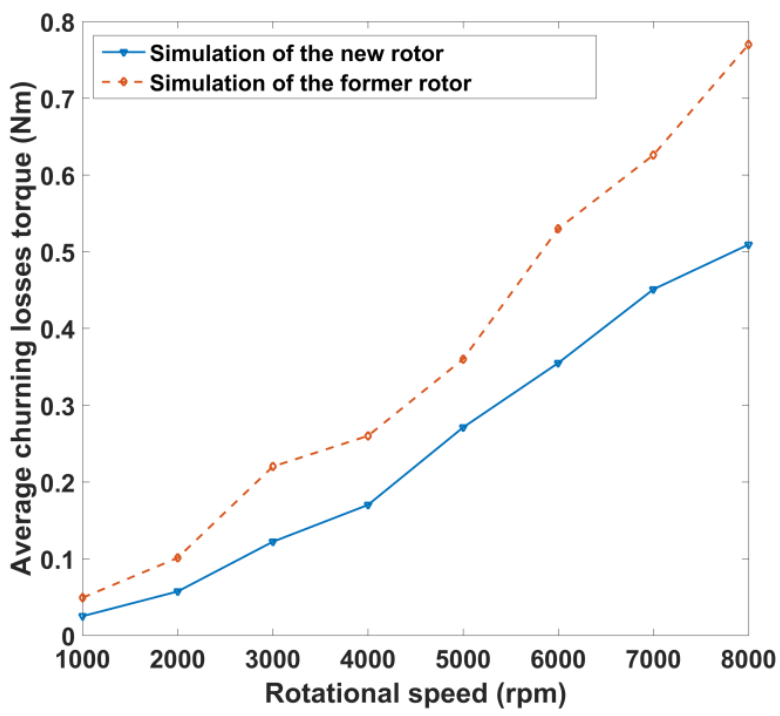
Figure 8. Comparison of the churning loss torques between the two rotors. More specifically, the pressure distributions on the two rotors were demonstrated at the two rotational speeds of 1000 rpm and 8000 rpm, as shown in Figure 9. Compared with the former rotor, the pressure distribution on the new rotor was much smoother and had a lower peak value at both rotational speeds. Meanwhile, the new rotor was certainly smaller than the former one since the reciprocating stroke of the 2D piston, the pump’s displacement, and rated working pressure were all the same. The smaller radial size, which indicates a larger gap between the outline of the rotor and the inner wall of the cylinder, resulted in a smaller shearing flow on the new rotor. In our study, the shearing flow took great responsibility for generating churning loss torque, especially at high rotational speeds.